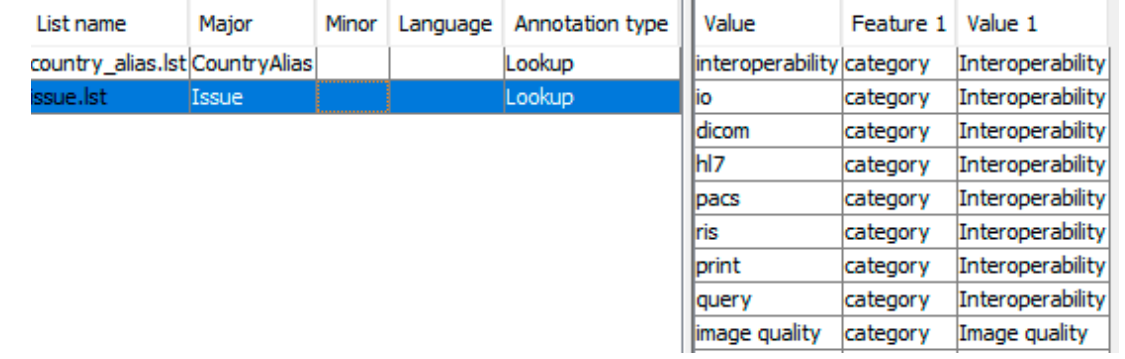
Figure 12. A snippet of the gazetteer list “issue.lst”.